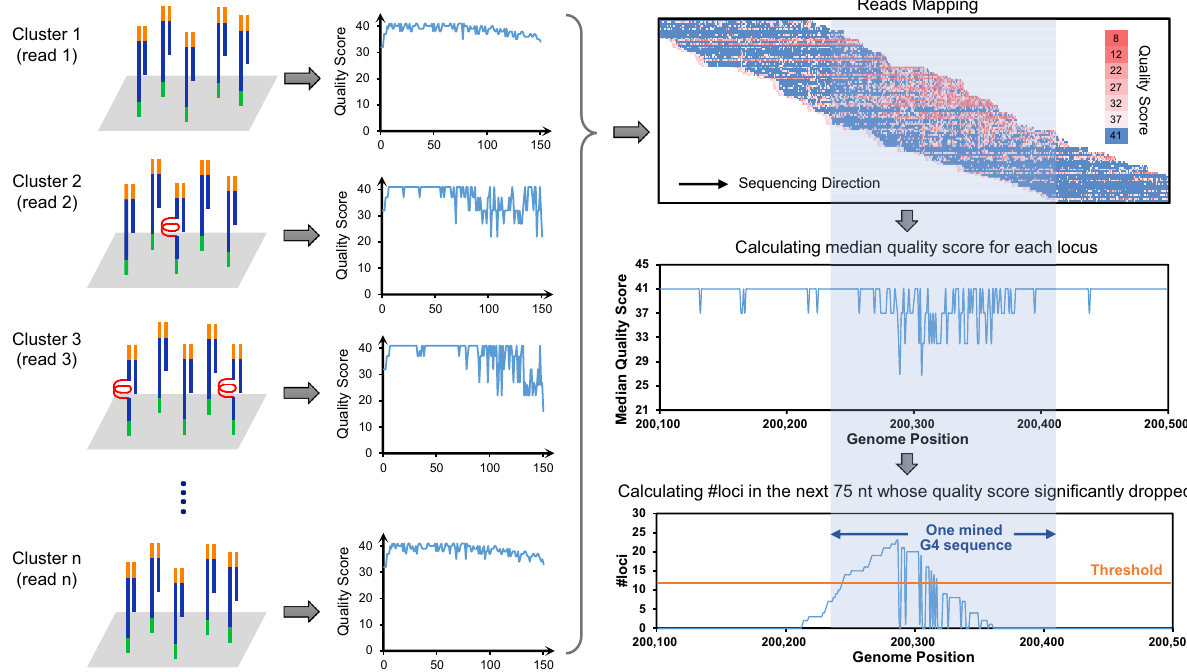
Fig. 1 A schematic of the G4-miner method. In a standard sequencing experiment, DNA fragments in clusters were sequenced, and the Phred quality scores were calculated for each read (cluster, orange and green parts are sequencing primers or adaptors, blue parts are the sequences to be determined, and the bent red parts are the sequences, which form G4 structures). The unstable formation of G4 causes unexpected fl uctuations in sequencing quality, but does not cause mismatches. Read mapping was performed to calculate the median quality score of bases mapped to each locus in the genome. For each site in the genome, the number of loci in the next 75 nt whose median quality score signi fi cantly dropped in comparison with that of the speci fi c site was calculated. G4 sequences in the whole genome can be mined after setting the threshold of the number of loci and the quality score dropped.